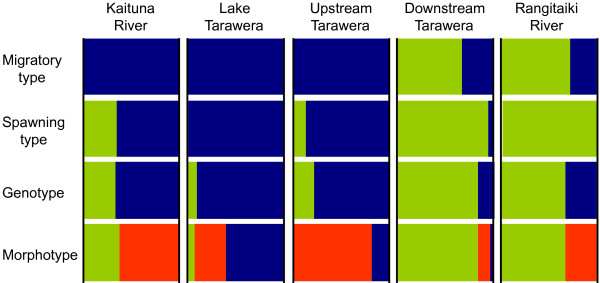
Summarized comparison of otolith, meristic, reproductive and genetic analyses. Sample locations are indicated above figure, with each characterized by four vertically arranged bar plots. Horizontal arrangements: Migratory type: light green = diadromous, dark blue = non-diadromous. Spawning type: light green = winter spawner, dark blue = summer spawner. Genotype: mean proportions of respective genotype (light green and dark blue) in population, colours refer to genotype as inferred by STRUCTURE (see also Figure 5). Morphotype: green (light) = Type 1, orange = Type 2, blue (dark) = Type 3.